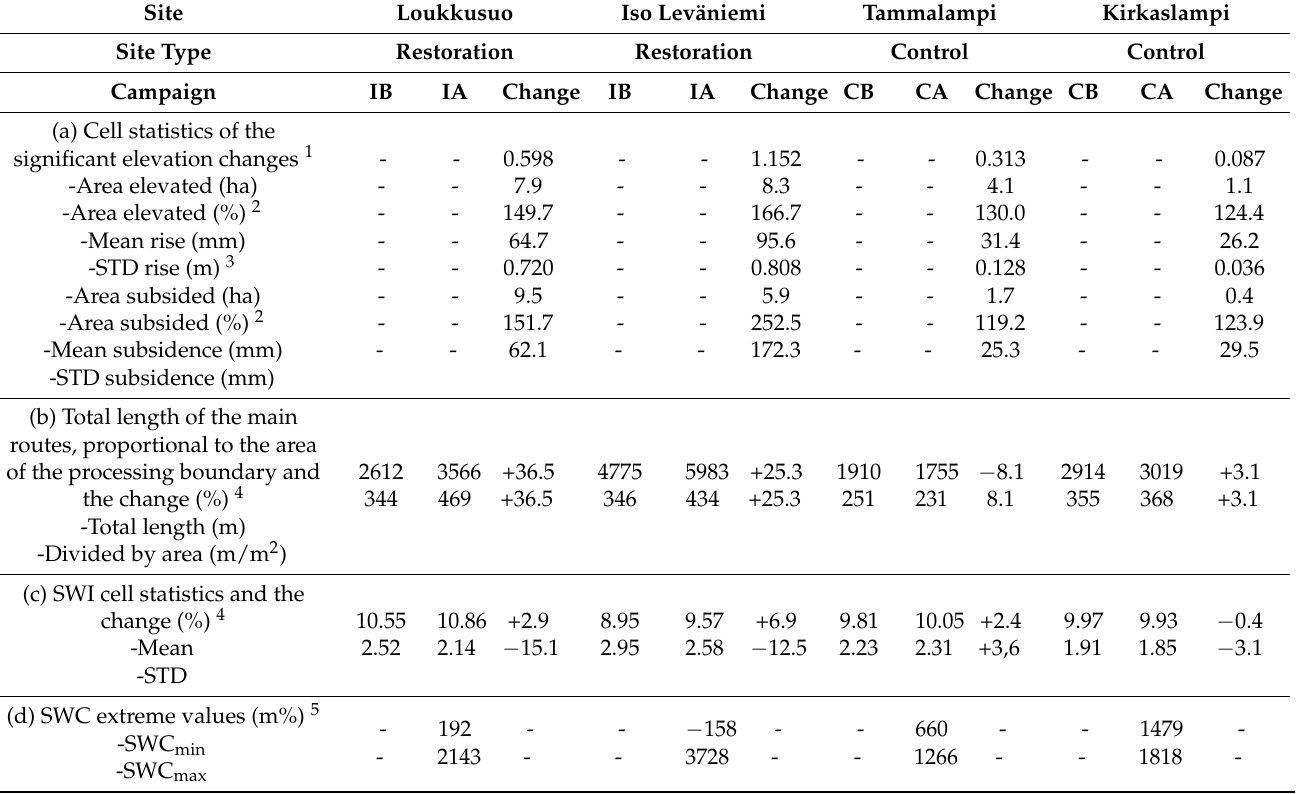
Table 4. Results of the topographic analysis such as the development in elevation (a), flow routes (b) and Saga Wetness Index (SWI) (c) and the site-specific scaling of the field-measured Soil Water Content (SWC) distribution (d). The changes represent restoration impacts for the IB-IA and DTM uncertainties for the CB-CA